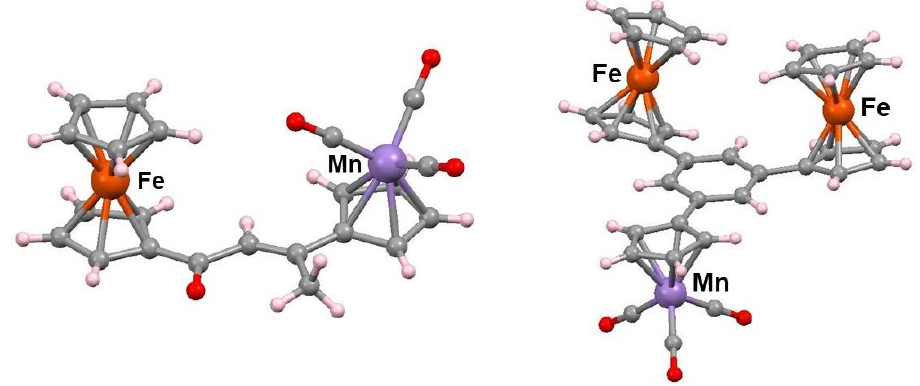
Figure 2. Molecular structures of the mixed iron-manganese complexes 36 and 37 .